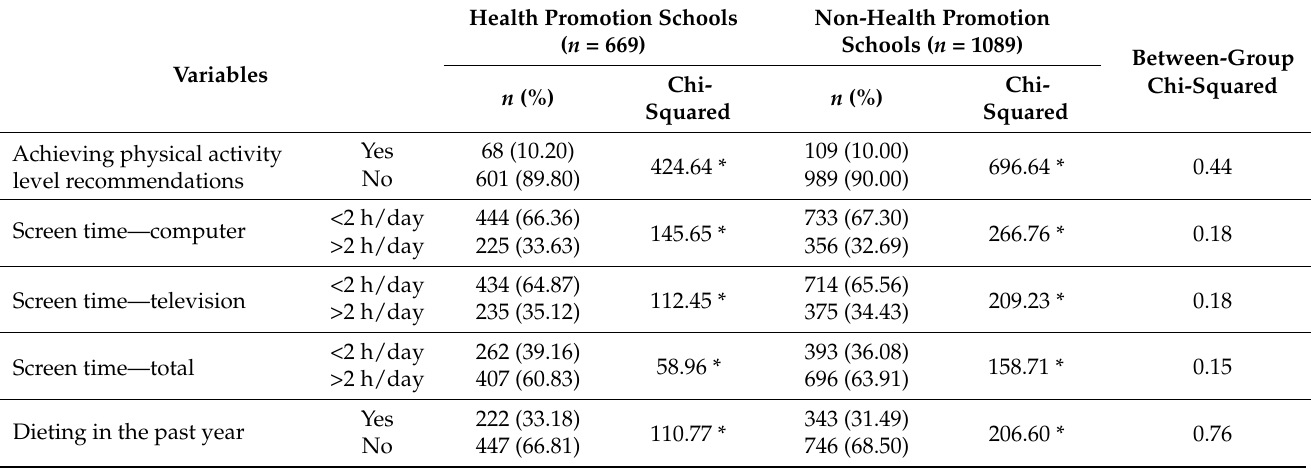
Table 2. Between-group differences in health behavior